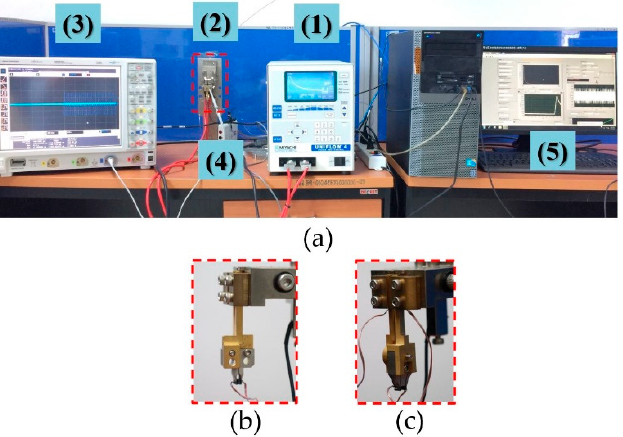
Figure 7. The experimental setup for ( a ) overview, ( b ), and ( c ) the enlarged figures to show prototypes of series and parallel WTs, respectively.